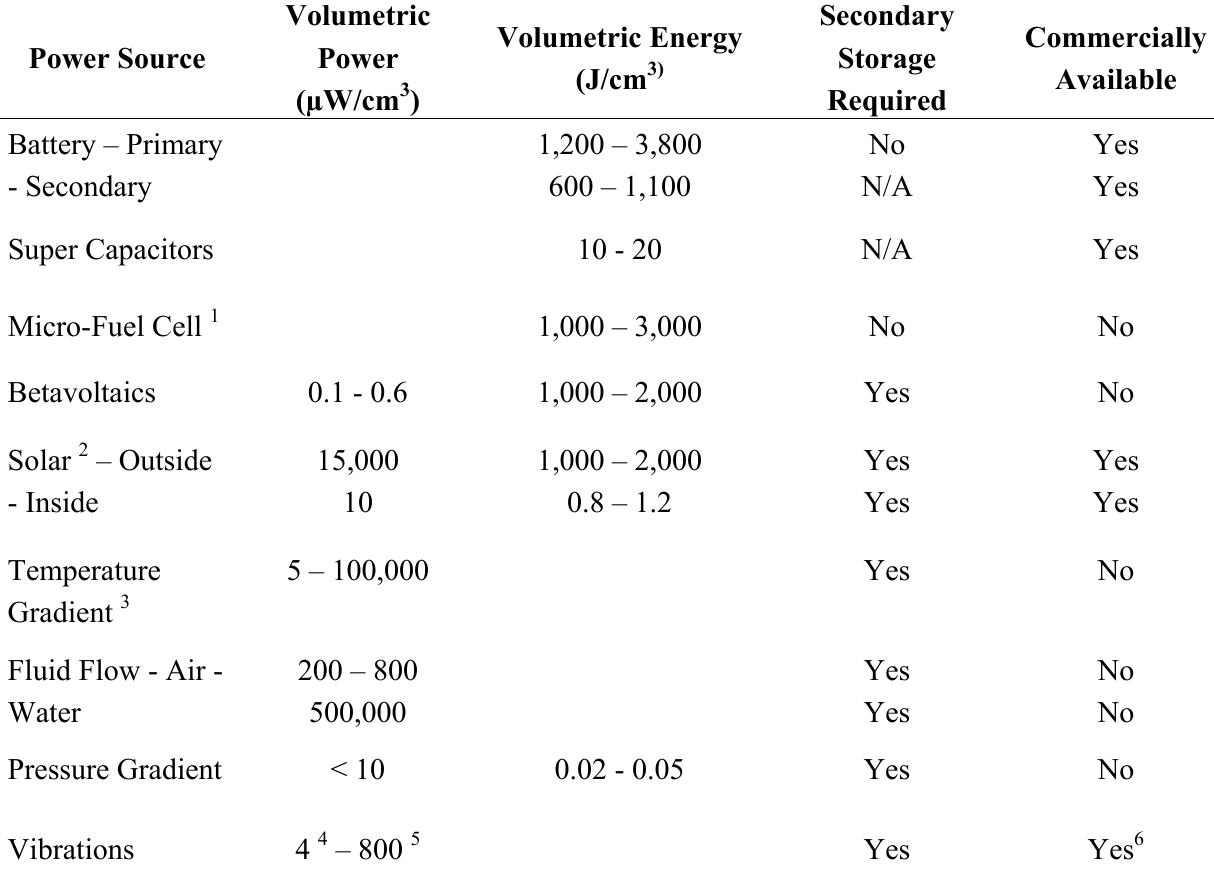
Table 4 . A summary of technologies (based on [7] with data from [4-5, 9, 11] and